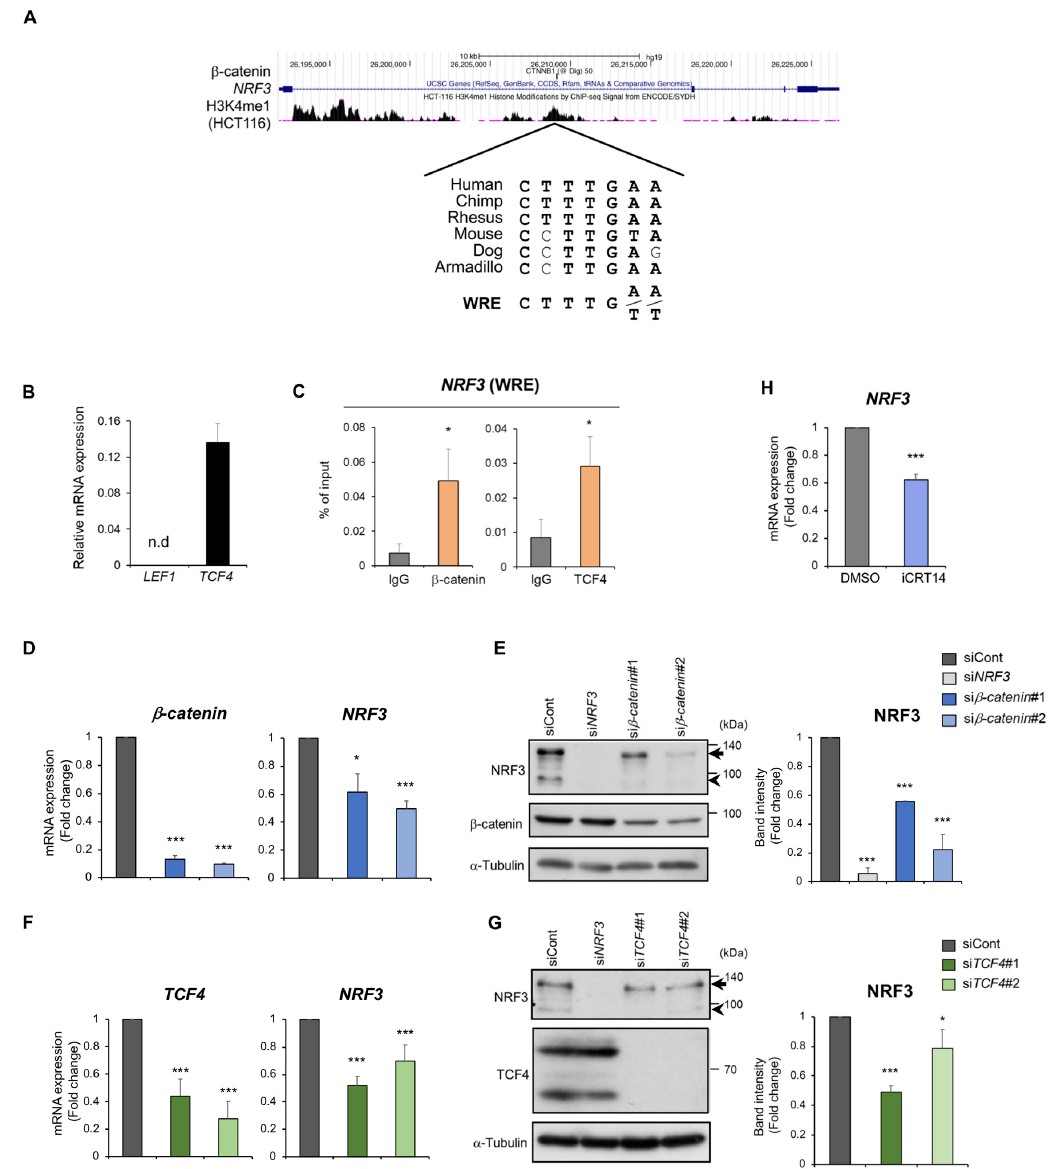
Figure 2. The β -catenin/TCF4 complex induces NRF3 gene expression in colon cancer cells. ( A ) Species conservation of the WRE site (TCF/LEF consensus element) in the NRF3 gene. ChIP peaks of β -catenin and histone H3K4me1 (a marker of a transcriptionally active locus) are shown from the UCSC Genome Browser data from ChIP-seq analyses of digestive tract-derived cells. ( B ) qRT-PCR shows the dominant expression of TCF4 rather than LEF1 in HCT116 cells. n.d., not detectable. ( C ) ChIP analysis using HCT116 cells indicated the binding of β -catenin and TCF4 to the WRE sequence in the NRF3 gene. ( D – G ) Knockdown of β -catenin ( D , E ) or TCF4 ( F , G ) significantly reduced NRF3 expression at both the mRNA ( D , F ) and protein levels ( E , G ). Two independent siRNAs against the indicated genes were transfected into HCT116 cells, and qRT-PCR and western blot analyses were performed 48 h after transfection. The arrows and arrowheads in the immunoblots indicate the cytoplasmic and nuclear forms of NRF3, respectively. An immunoblot using an anti-TCF4 antibody showed two splicing variants of the TCF4 protein ( G ). ( H ) The β -catenin/TCF4 complex inhibitor iCRT14 also suppressed NRF3 mRNA expression in HCT116 cells. mRNA and protein expression were normalized to β -actin mRNA and α -Tubulin protein expression, respectively. The data are presented as the mean ± SD ( n = 3). * p < 0.05, *** p < 0.005 ( t -test in C and H, ANOVA/Tukey in D – G ).